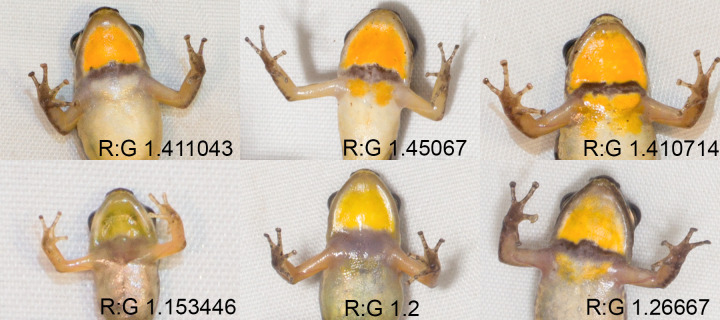
Variation in the throat colouration of female M. trinitatis.Variability in throat patch relative size and shape, collar width and intensity, and extension of the colour posterior to the collar. R:G denotes the Red:Green ratio as extracted from photographs.